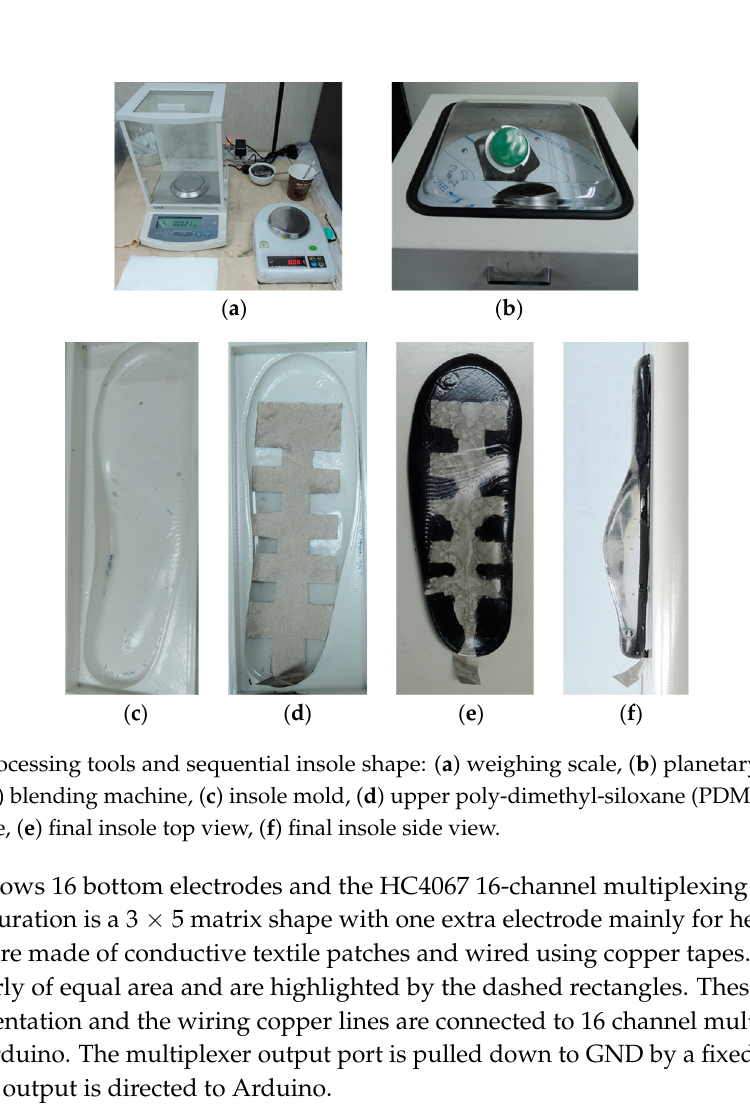
Figure 3. Insole fabrication sequence.